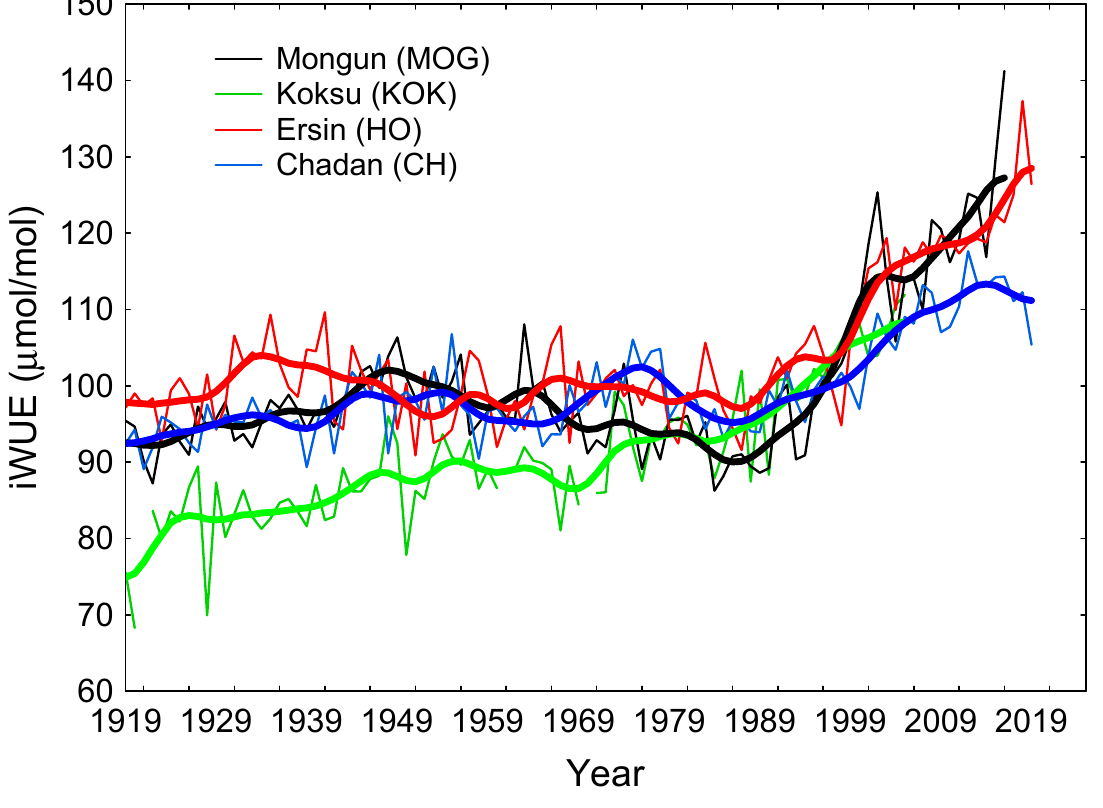
Figure 2. Annual and smoothed by a 11-year Hamming window intrinsic water use efficiency (iWUE) calculated for the Mongun (MOG, black line), Koksu (KOK, green line), Ersin (HO, red line), and Chadan (CH, blue line) sites. Vertical dashed line represents the start of a rapid increase in the iWUE trends for all studied sites. The years of 1921, 1961, and 1970 are missing for the KOK site.